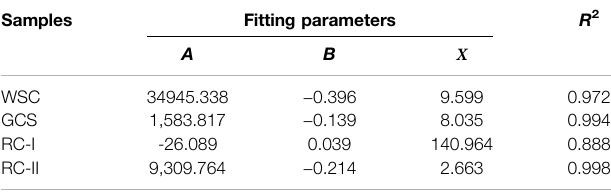
TABLE 3| Fittingresultsforrelationshipbetweenthecohesionand watercontent.